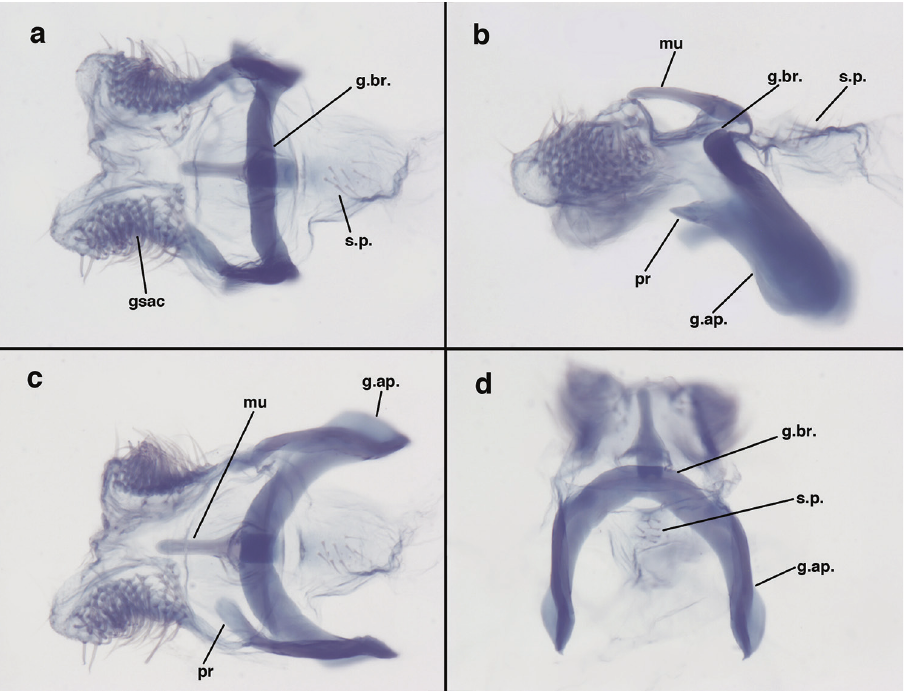
Figure 47. Ungla grandispiracula Tauber, sp. n. Male genitalia, ( a ) gonarcal complex, dorsofrontal, ( b ) gonarcus, lateral ( c ) gonarcal complex, dorsal, gonosaccus fully expanded ( d ) gonarcal complex, pos- terior. gsac gonosaccus g.ap. gonarcal apodeme g.br. gonarcal bridge mu mediuncus pr unarticulated process on frontal margin of gonarcal apodeme s.p. setose subanal plate (all: Colombia, Valle del Cauca, paratype,